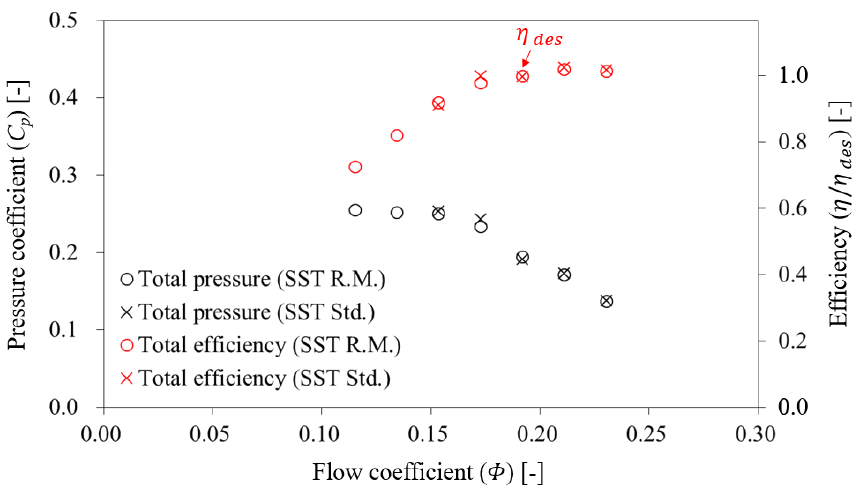
Figure 10. Performance curve for the influence of the turbulence models.